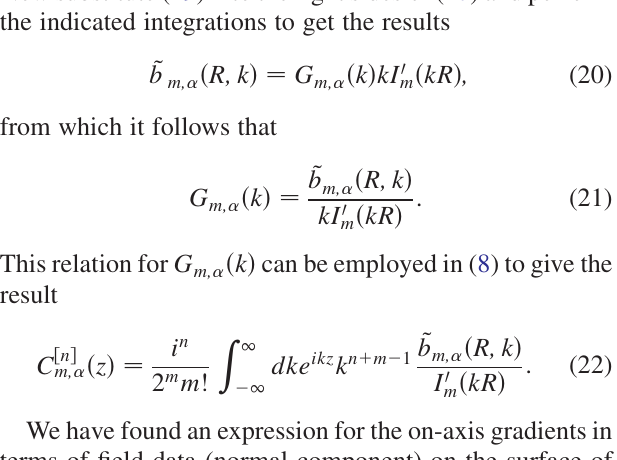
FIG. 3. (Color) An elliptical cylinder, centered on the z axis, fitting within the bore of a wiggler, and extending beyond the fringe-field regions at the ends of the